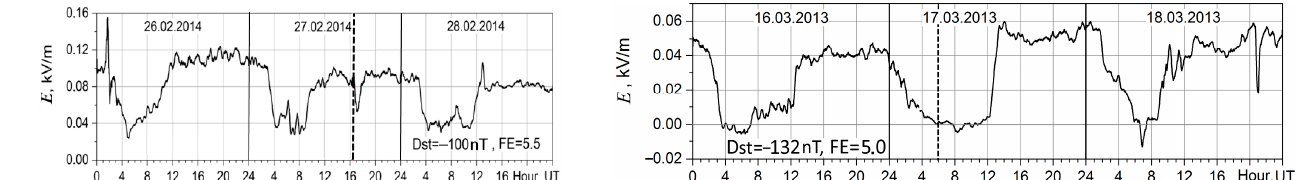
Figure 5. Values of the atmospheric electric field after the CME 27.02.2014 and 17.03.2013. The Dst and FE values are shown in the figure field. The vertical solid line indicates the boundaries of the day; the dashed vertical line indicates the beginning of the FE.